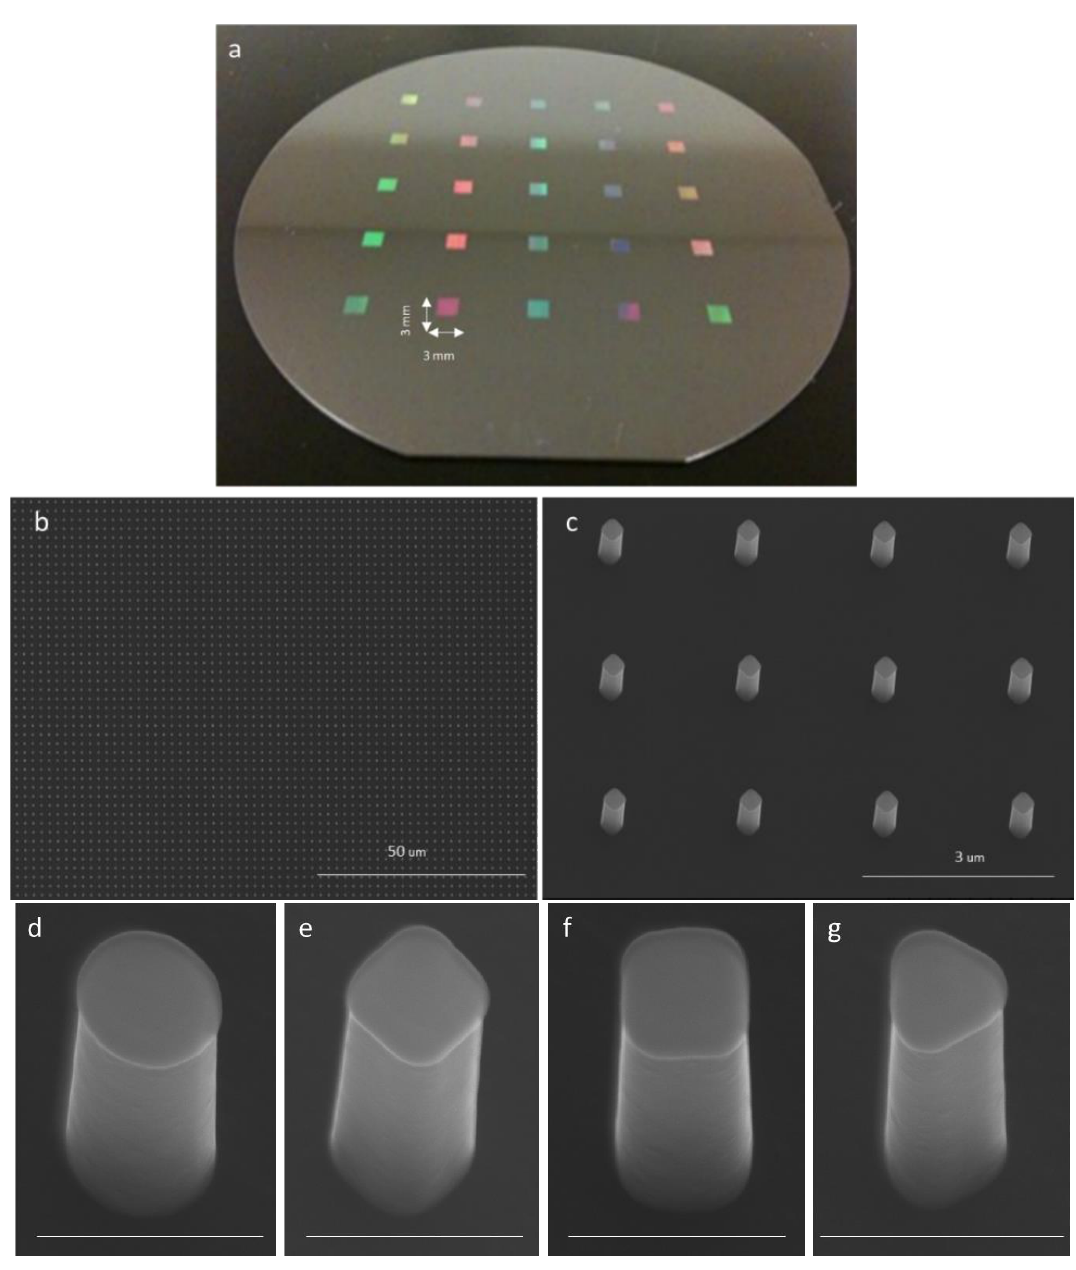
Figure 2. ( a ) Fully fabricated nanoarrays on Si wafer; each square dimensions 3 mm × 3 mm; ( b , g ) SEM images of different shaped TiO 2 - and SiO 2 /TiO 2 -coated post arrays. Scale: ( b ) 50 µm, ( c ) 3 µm, ( d – g ) 500 nm for all SEM images. Table 1. Dimensions of different shaped mesoscale TiO 2 - and SiO 2 -TiO 2 coated pillar arrays. - TiO 2 -coated SiO 2 -TiO 2 -coated Spheres